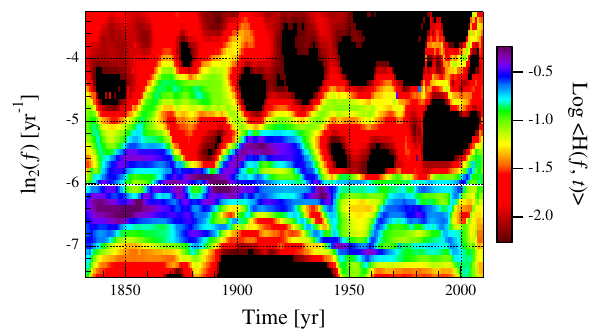
Fig. 6. Ensemble averaged Hilbert spectrum h H(T,t) i reported on Fig. 5. Ensemble averaged Hilbert spectrum h H(f,t) i plotted on Fig. 6. Ensemble averaged Hilbert Spectrum h H ( T,t ) i reported in the time-period plane. The horizontal white Fig. 5. Ensemble averaged Hilbert Spectrum h H ( f,t ) i plotted in the time-frequency plane. Frequency resolu- the time–period plane. The horizontal white line indicates the 65yr Fig. 6. Ensemble averaged Hilbert Spectrum h H ( T,t ) i reported in the time-period plane. The horizontal white the time–frequency plane. Frequency resolution is 0.1 in the ln 2 (f ) . characteristic periodicity. line indicates the 65 yr characteristic periodicity. tion is 0.1 in the ln 2 ( f ) . The horizontal white line indicates the 65 yr characteristic periodicity. The horizontal white line indicates the 65yr characteristic periodic- line indicates the 65 yr characteristic periodicity. ity.